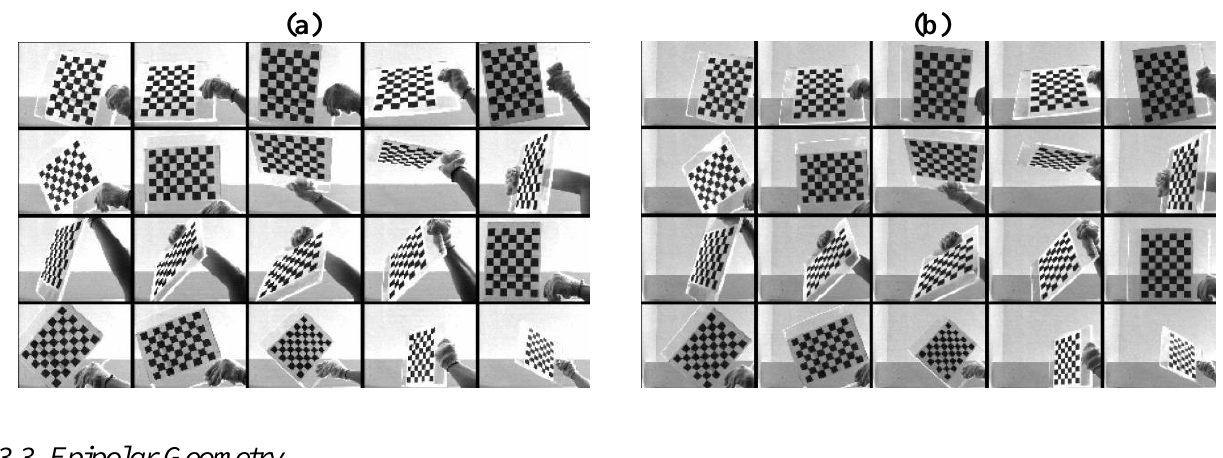
Figure 5. The calibration patterns. (a) Left images; (b) Right images.